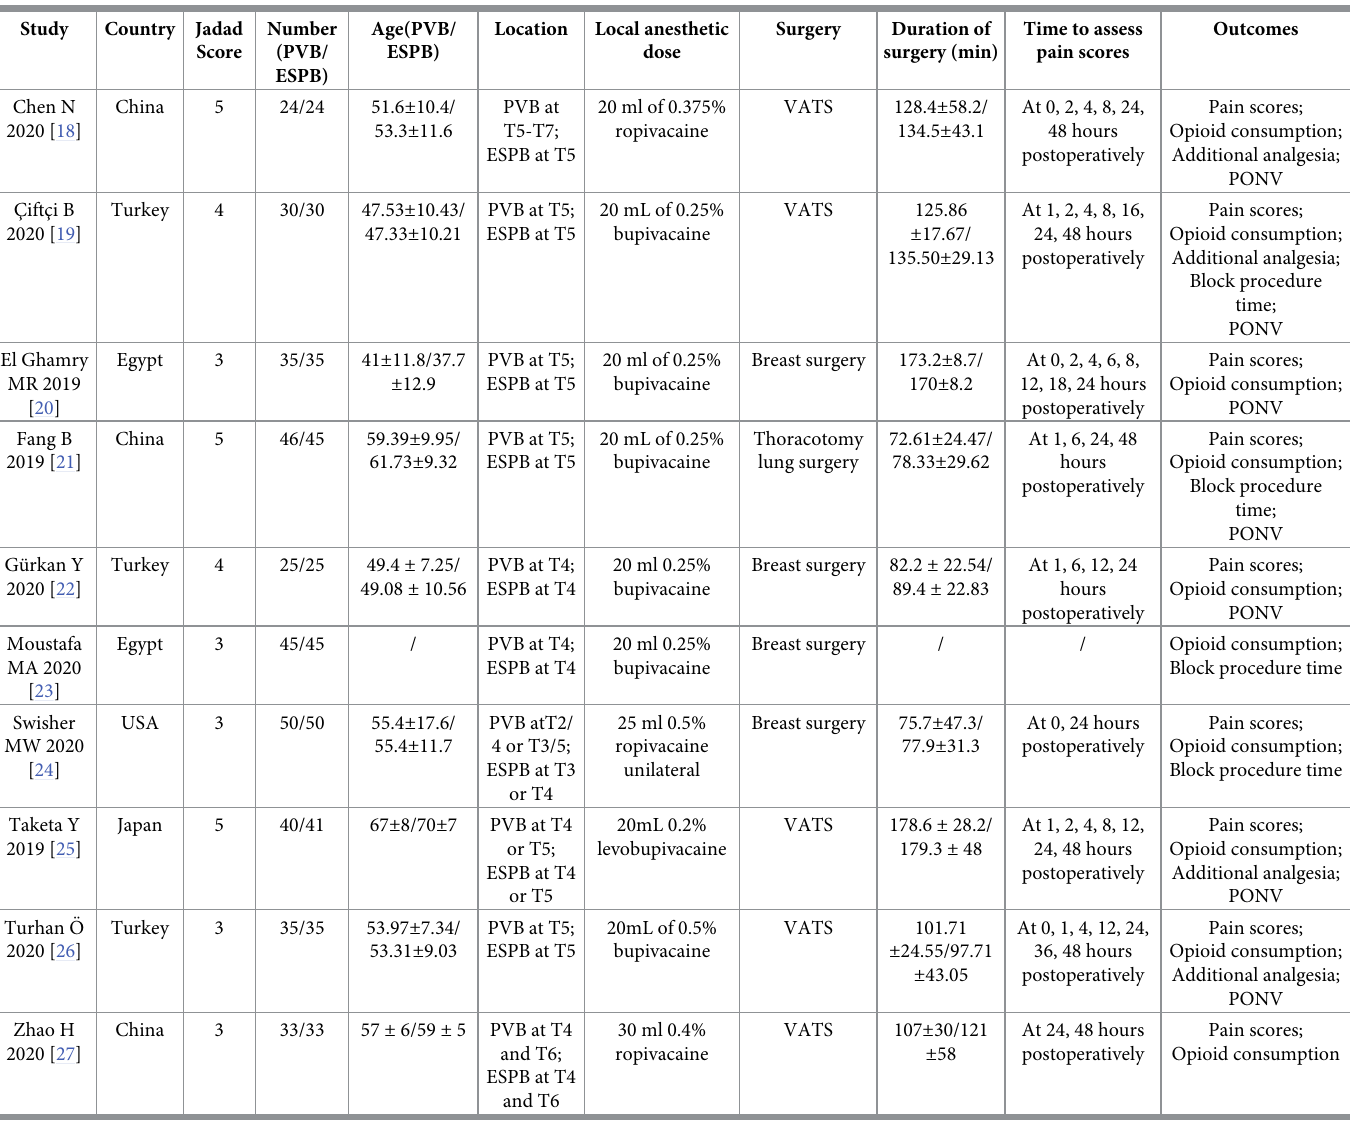
Table 1. Characteristics of 10 included